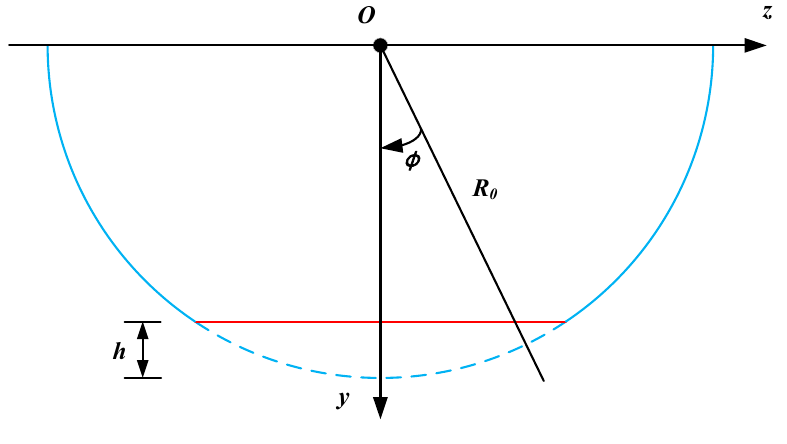
Figure 3. Geometric form of wheel flat.